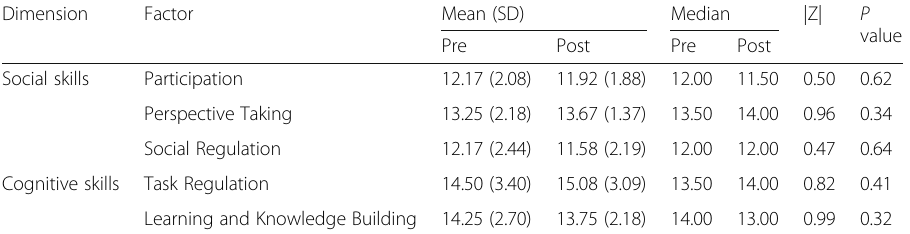
Table 5 Wilcoxon signed-rank test results for the CPS pre-postquestionnaires Dimension